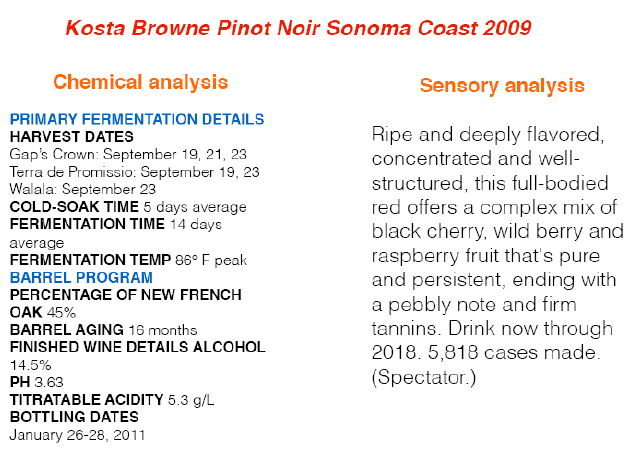
Figure 1. The review of the Kosta Browne Pinot Noir Sonoma Coast 2009 (scores 95 pts) on both chemical and sensory analysis